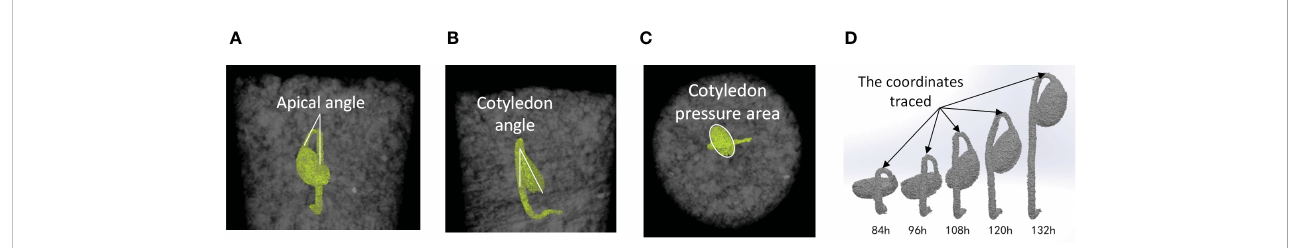
FIGURE 1 Examples of CT images of soybean seedling at time (t); images from Test No. 5. (A) Apical angle of hypocotyl in the X-Z plane at t=108 (h) (B) Rotation angle of cotyledon in the Y-Z plane at t=108 (h) (C) Pressure area of cotyledon in the X-Y plane at t=108 (h) (D) Locations on hypocotyl where the coordinates were monitored to trace the direction of seedling growth.